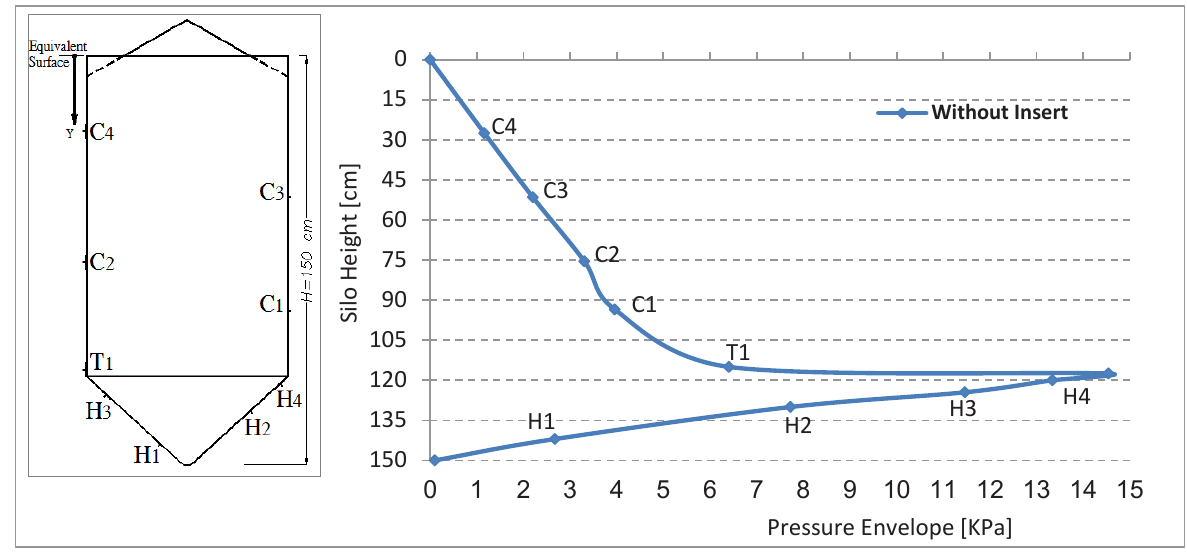
Fig. 6 The pressure distribution on the silo wall and hopper without using Insert